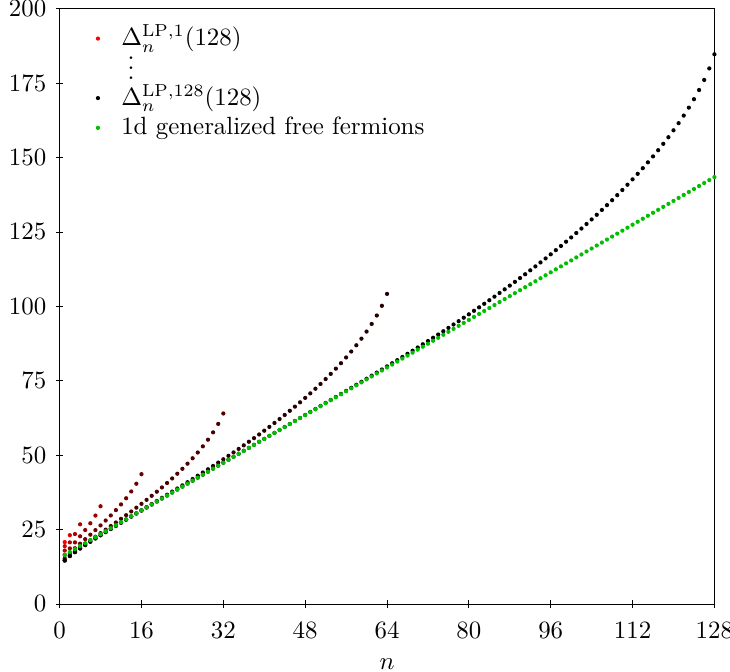
Figure 6 . The spectrum for c = 128 computed using truncation order N = 1 , 2 , 4 , . . . , 128 (red through black) and the free fermion spectrum ∆ n ( c ) = n + ( c − 4) / 8